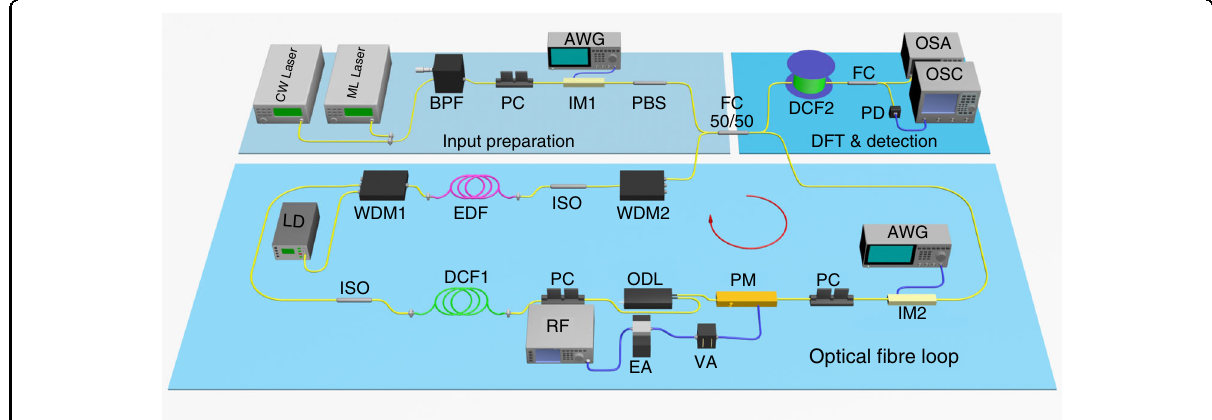
Fig. 2 Schematic of the experimental setup based on a fi bre-loop circuit. CW Laser continuous-wave laser, ML Laser mode-locked laser, BPF bandpass fi lter, PC polarisation controller, AWG arbitrary waveform generation, IM intensity modulator, PBS polarisation beam splitter, FC fi bre coupler, RF radio-frequency signal generator, EA electrical ampli fi er, VA variable attenuator, ODL optical delay line, DCF dispersion-compensating fi bre, ISO isolator, LD laser diode, WDM wavelength-division multiplexer, EDF erbium-doped fi bre, PD photodetector, OSC oscilloscope, OSA optical spectrum analyser. The red circle represents the propagation direction of the circling